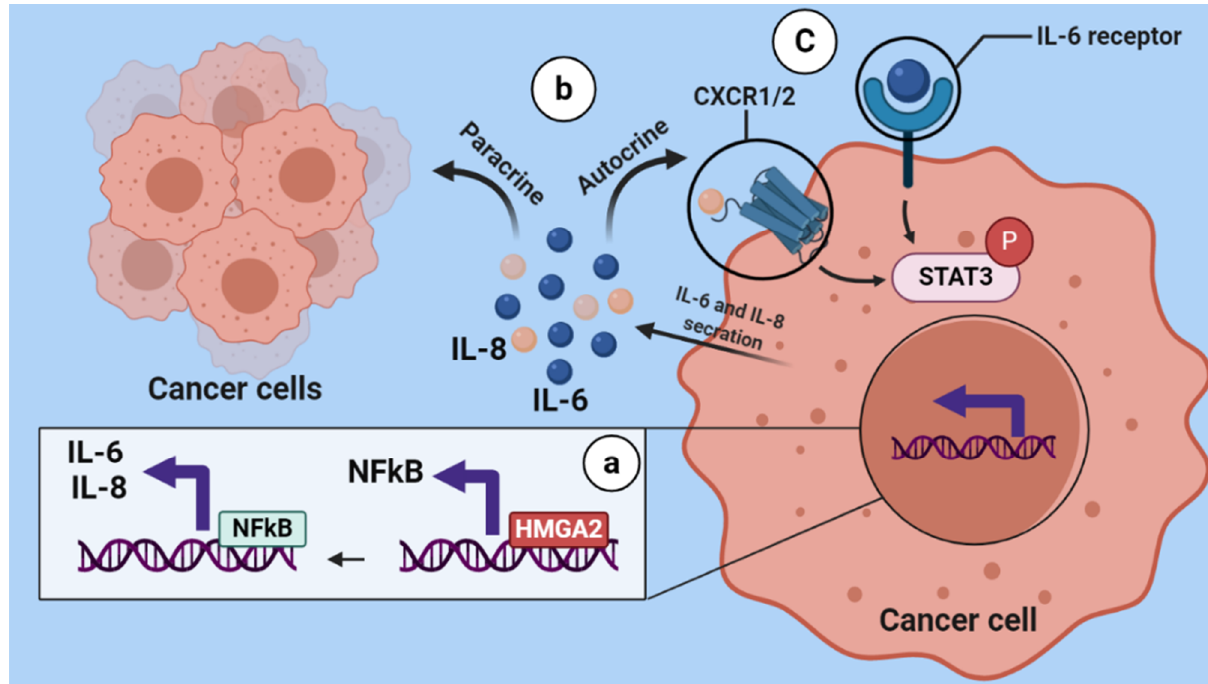
Figure 9. Schematic illustration of regulation of HMGA2 on the NF-κB/IL-6/IL-8/STAT3 axis. HMGA2 as DNA binding protein increases the expression of NFkB, then NFkB increases the secretion of IL-6 and IL-8 from breast cancer cells (a). IL-6 and IL-8 which are released from tumoral cells can bind to their receptor in an autocrine and paracrine manner (b). Subsequently, this binding causes STAT3 signaling activation (C).